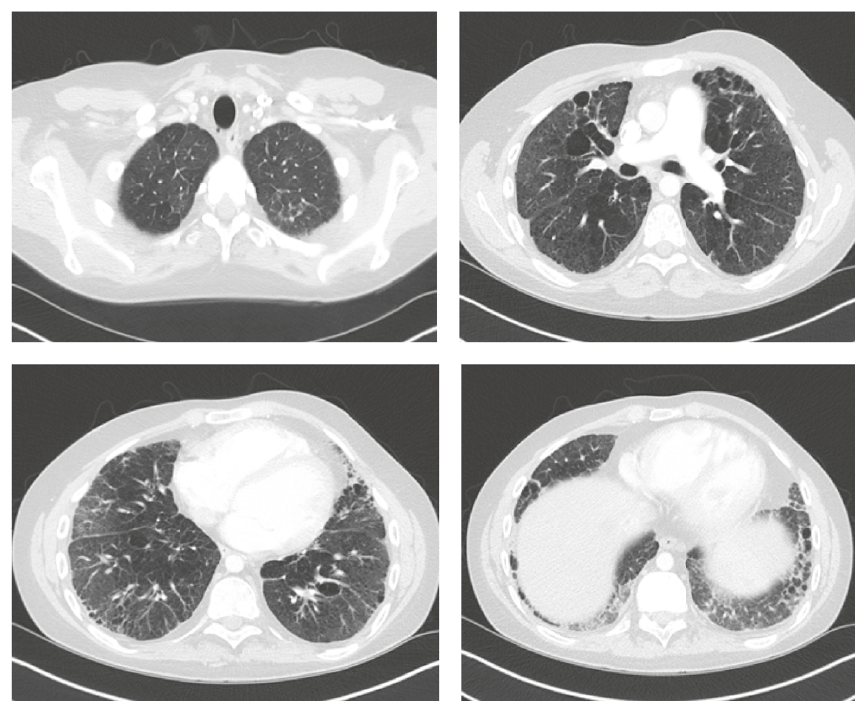
Figure 2: CT of chest showed progressive fibrosis, with increased numbers of lung small cysts, as well as area of emphysema. Additional finding included subpleural honeycombing and mosaic